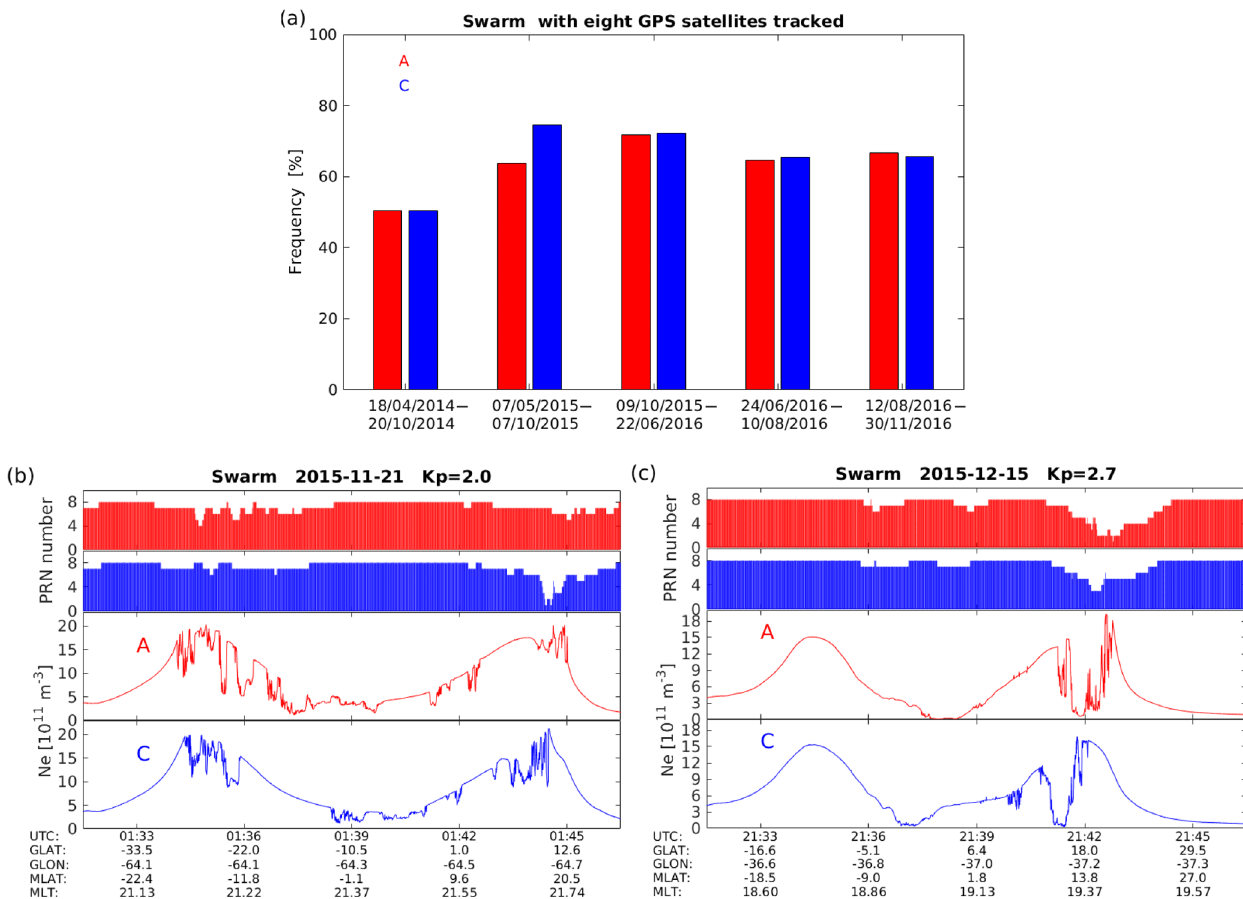
Figure 9. (a) The occurrence of tracked GPS satellites at all eight channels for Swarm A (red) and C (blue) during five different periods: (1) from 18 April 2014 to 20 October 2014 when the FOV and PLL bandwidth have not been updated for both satellites; (2) from 7 May 2015 to 7 October 2015 when the FOV of both Swarm A and C have increased from 80 to 88 ◦ , while the PLL bandwidth is 0 . 25 and 0 . 5Hz for Swarm A and C; (3) from 9 October 2015 to 22 June 2016 when the PLL bandwidth is both 0.5Hz for Swarm A and C; (4) from 24 June 2016 to 10 August 2016 when the PLL bandwidth is 0 . 5 and 0 . 75Hz for Swarm A and C; and (5) from 12 August 2016 to 30 November 2016 when the PLL bandwidth is 0 . 75 and 1 . 0Hz for Swarm A and C. (b) and (c) are two examples of equatorial plasma irregularities observed by Swarm A and C during the third period when both the FOV and PLL bandwidth have been updated. However, the GPS receivers onboard both satellites were still found with signal loss at some channels during both